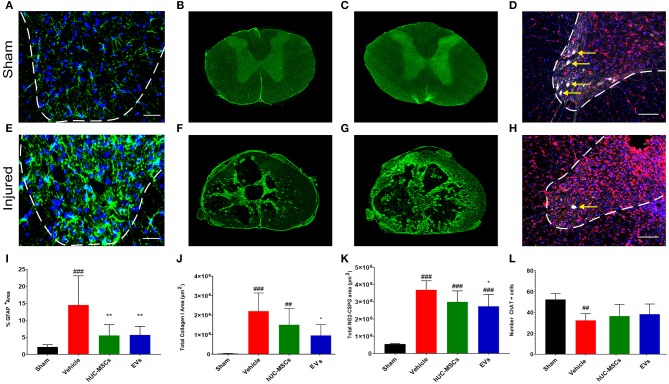
Immunodetection of various markers expressed in the spinal cord of a sham rat (A–D) and in a rat following tSCI (E–H). Immunodetection of GFAP-expressing astrocytes in the ventral horn of sham operated and injured rats (2 mm rostral from the epicenter) (A,E). Scale bar (A,E) = 50 μm, ventral horn deliminated with dashed lines. Immunodetection of Collagen I in the spinal cord of sham and injured rats (lesion epicenter) (B,F). Immunodetection of NG2-CSPGs in the spinal cord of sham and injured rats (lesion epicenter) (C,G). Immunodetection of ChAT-expressing motor neurons (white, yellow arrows) and Iba1-expressing microglia (red) in the spinal cord of sham and injured rats (2 mm rostral from the epicenter) (D,H). Nuclear counterstain with DAPI (blue). Scale bar (D,H) = 100 μm, ventral horn deliminated with dashed lines. (I) Percentage of area covered by GFAP at 2 and 3 mm rostral and caudal from the lesion epicenter in the ventral horn. Total area covered by Collagen I (J) and NG2-CSPG (K) depositions were quantified on spinal cord sections ranging from 3 mm rostral to 3 mm caudal from the lesion epicenter. The equivalent positions along the rostro–caudal axis were used to measure the area covered by collagen I and CSPG-NG2 in the spinal cord of the sham group. (L) Total number of ChAT+ motor neurons quantified in the ventral horns of the spinal cords at 2 and 3 mm both rostral and caudal from the lesion epicenter and at the equivalent positions along the rostro–caudal axis of the sham operated rats. (I–L) Groups were compared using one-way ANOVA and Bonferroni post-hoc test. Statistical significances compared to sham group: ##p ≤ 0.01; ###p ≤ 0.001, statistical significances compared to vehicle group: *p ≤ 0.05; and **p ≤ 0.01.